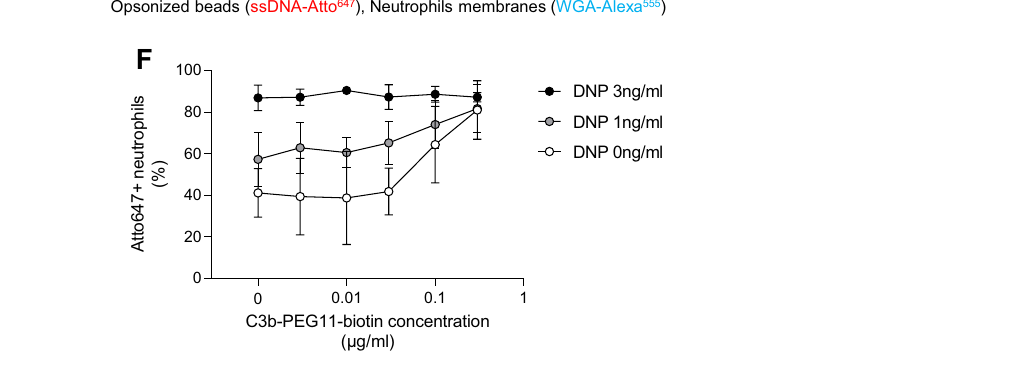
Figure 4. Quenching assay of C3b-beads vs. IgG1-beads by human neutrophils. ( A ) Illustration of the method used to label beads for the quenchable phagocytosis assay. Beads are reacted with DBCO-NHS, which covalently binds the azide-functionalized oligomer fluorescently labelled with Atto647 “ Oligo-Atto647 ”. The fluorophore is quenched by hybridization with the complementary oligomer bound to BlackBerry Quencher (BBQ). ( B,C ) Uptake of empty, IgG- and C3b- beads evaluated in the presence (black) or absence (white) of the quencher. Results are expressed in terms of: ( B ) mean Atto647 fluorescence intensity of the total neutrophil population and ( C ) percentage of Atto647-positive neutrophils in the total population. ( B,C ) represent the Mean ± SD of 3 independent experiments. ( D,E ) Confocal microscopy images of a representative phagocytosis assay of Atto647-beads incubated in the presence of ( D ) 3 µg/mL IgG1 anti-DNP or ( E ) 1 µg/mL C3b-biotin. Staining information: red = ssDNA Atto647, (fluorescently-labelled single-stranded DNA oligonucleotide), blue = Wheat Germ Agglutinin-Alexa fluor 555 (lectin binding β-1,4-N-Acetylglucosamine carbohydrate residues on membranes). ( F ) Uptake of beads opsonized with increasing concentrations of combined anti-DNP IgG and C3b-biotin expressed as percentage of Atto647-positive neutrophils in the total population. Mean ± SD of 3 independent